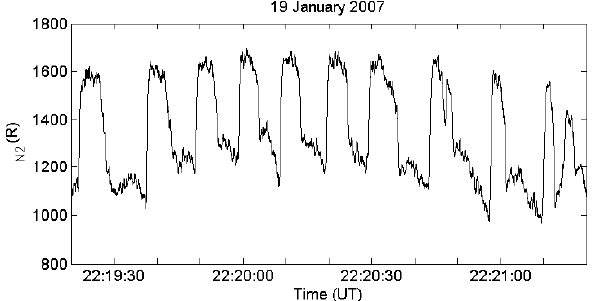
Figure 6. Dips have also been seen just before the ON period of pulsations, but often with a slow decrease in brightness to reach a minimum value, as is shown here in the I N 2